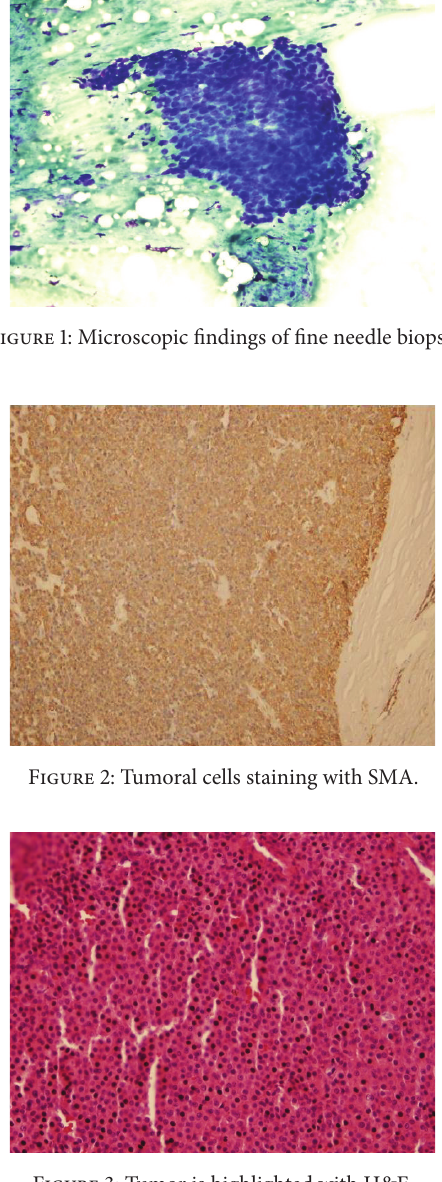
Figure 3: Tumor is highlighted with